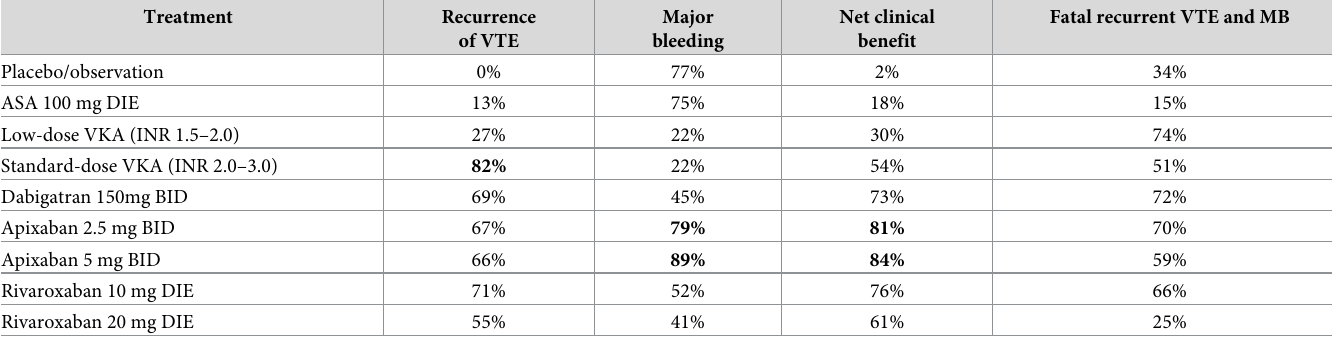
Table 3. Probability of being the best treatment according to the p-score computing using frequentist network meta-analysis. Treatment Recurrence